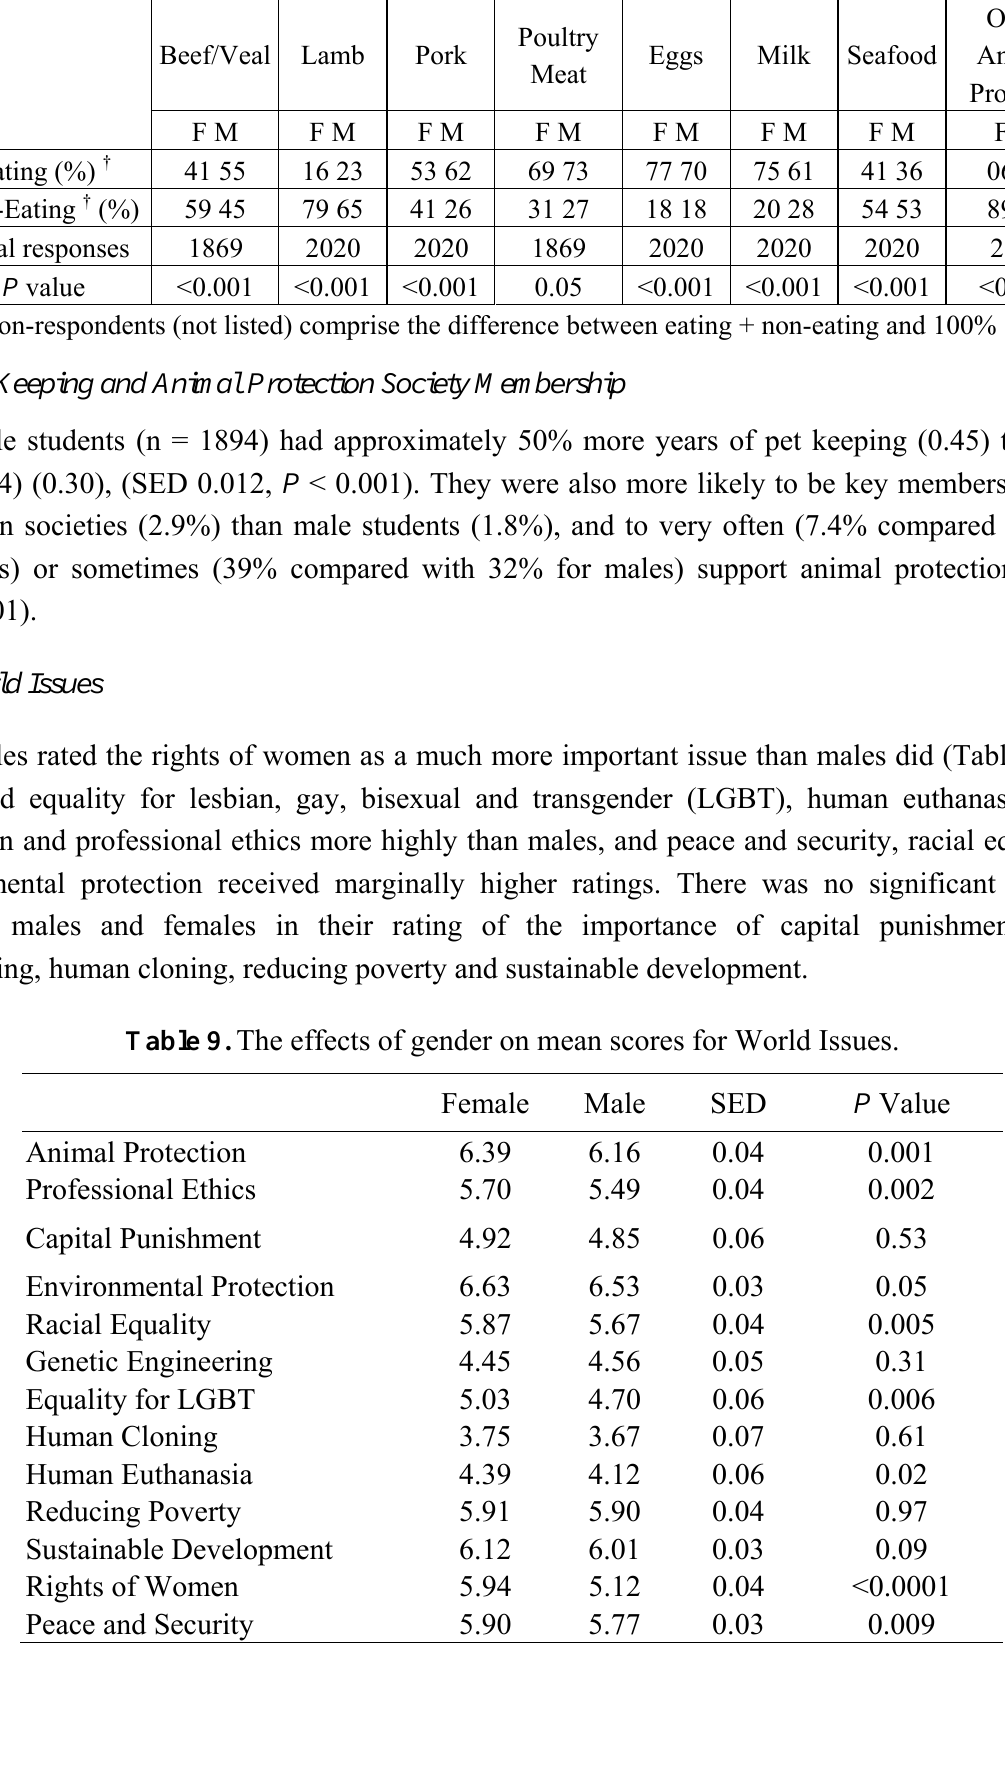
Poultry Eggs Milk Seafood Lamb Pork Meat